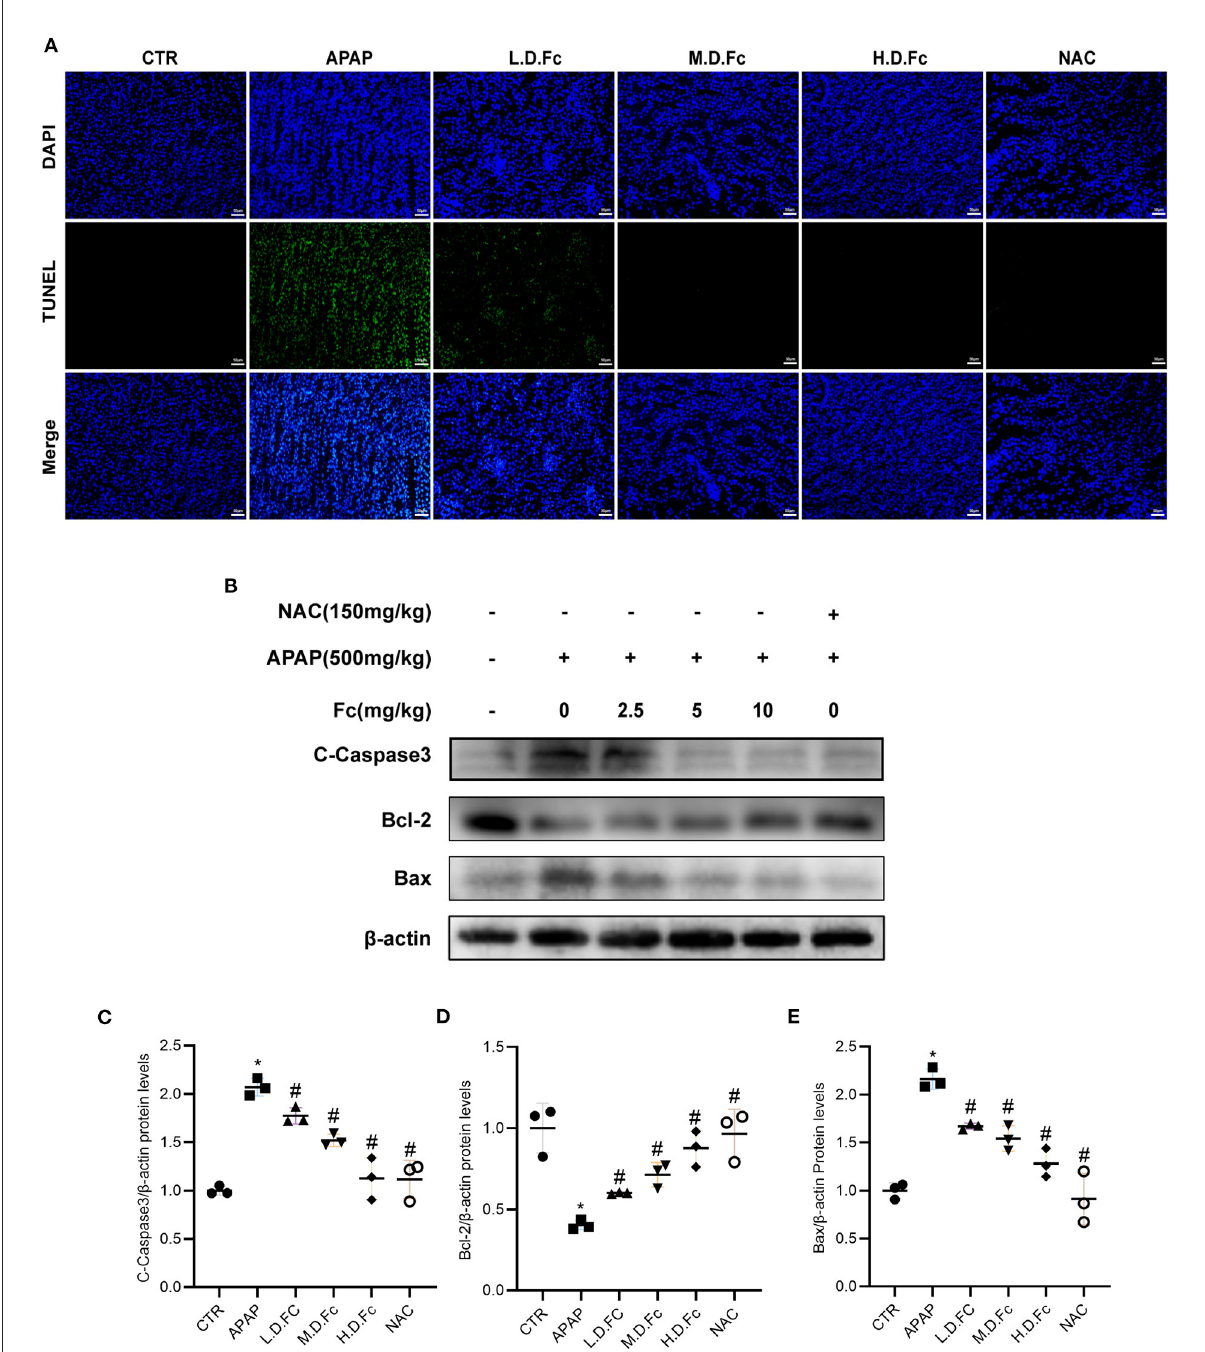
FIGURE3 Notoginsenoside Fc attenuated renal tubular cells apoptosis in AKI mice. (A) Representative double immunofluorescence labeling, including the TUNEL assay and DAPI on frozen kidney sections. (B–E) Representative images of Bcl-2, Bax and C-Caspase3 protein expression and semiquantitative analyses in different groups. Results were expressed as mean ± SD. * P < 0.05 vs. normal control mice. # P < 0.05 vs. APAP-induced AKI mice.